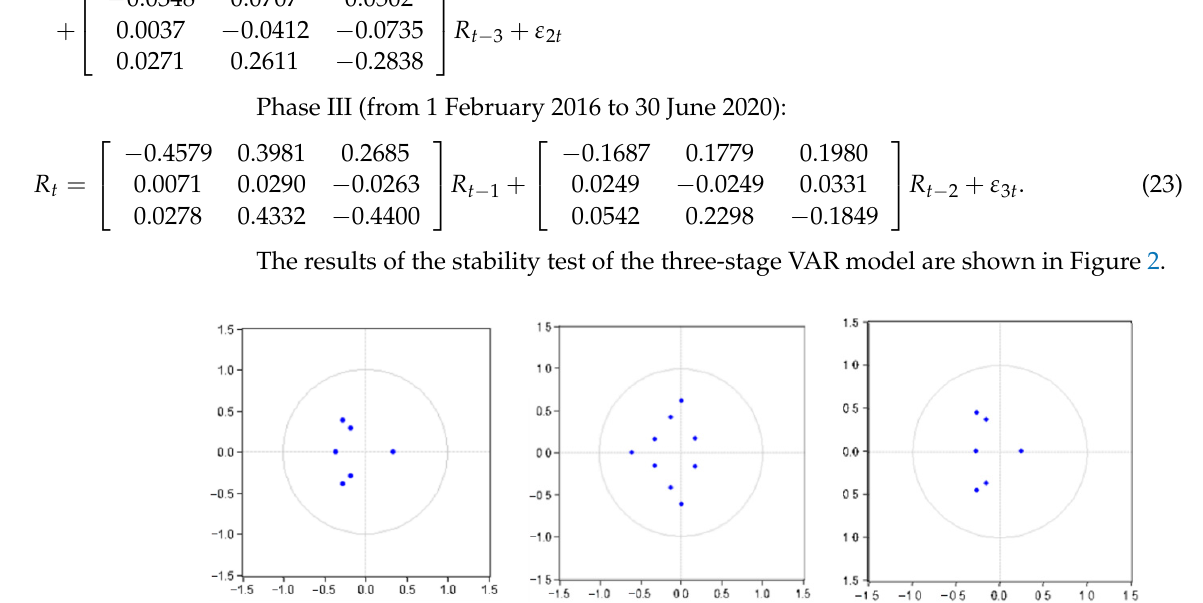
Figure 2. Unit circle of the VAR model in three stages.